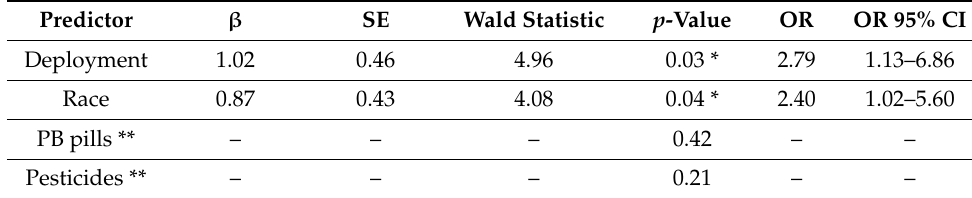
Table 4. Logistic regression for predictors of GWI symptoms. Predictor β SE Wald Statistic p -Value OR OR 95% CI